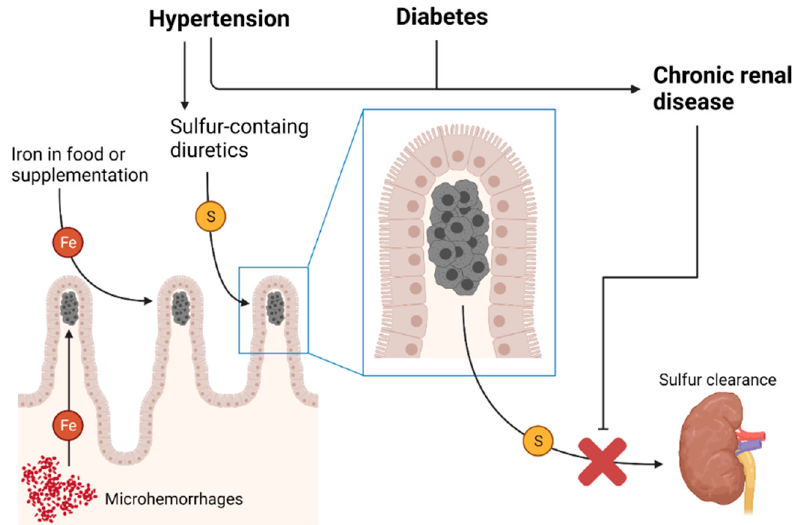
Figure 3. An overview of the possible pathogenesis of duodenal pseudomelanosis. The macrophages in the lamina propria at the apex of the villi contain, in most cases, sulfur (S), which is contained in some diuretics, and iron (Fe), which could accumulate due to binging with sulfur after absorption or microhemorrahgic events. Chronic renal disease causes reduced sulfur clearance, contributing to its accumulation. (Created with BioRender.com)